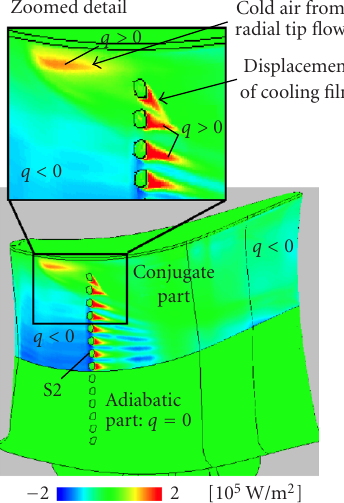
Figure 10: Specific heat transfer rate distribution on the suction